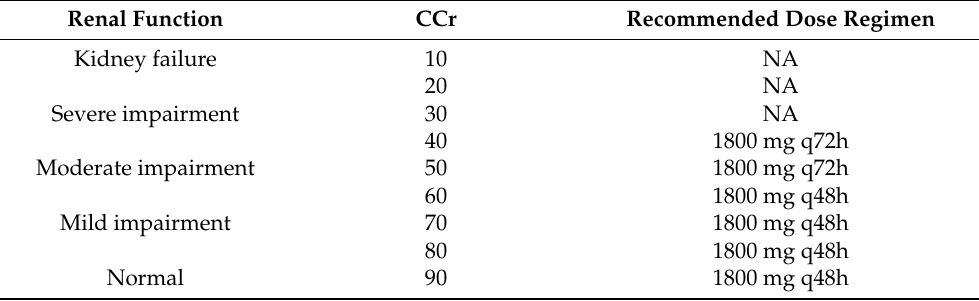
Table 5. Recommended amikacin dosing regimens for patients with CCr of 10–90 mL/min. Renal Function CCr Recommended Dose Regimen Kidney failure 10 NA 20 NA Severe impairment 30 NA 40 1800 mg q72h Moderate impairment 50 1800 mg q72h 60 1800 mg q48h Mild impairment 70 1800 mg q48h 80 1800 mg q48h Normal 90 1800 mg